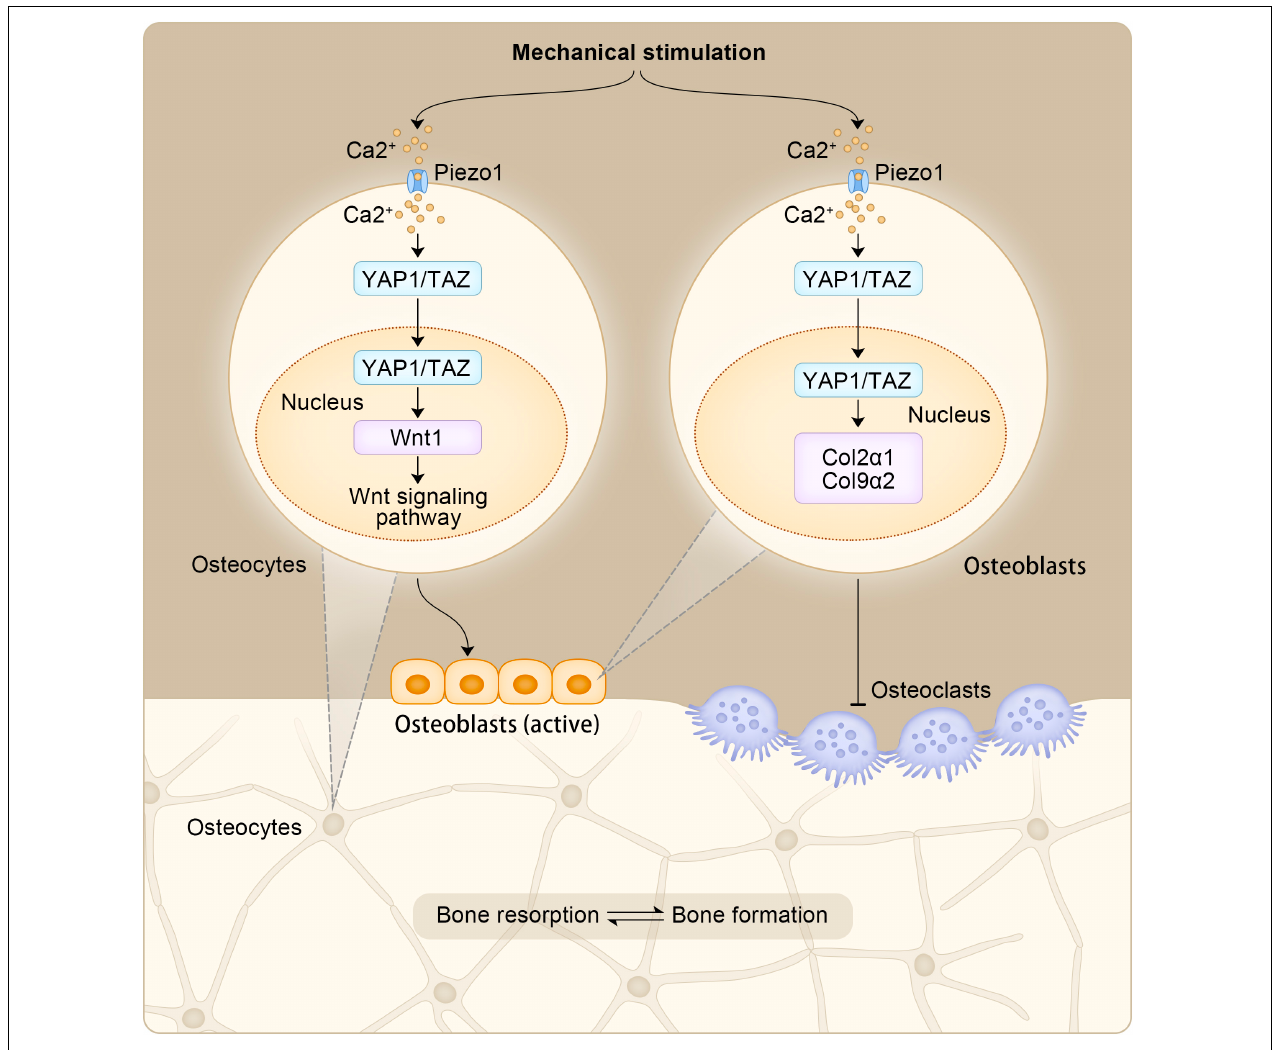
FIGURE 4 | The effects of Piezo1 mediated mechanical stimulation in OB and